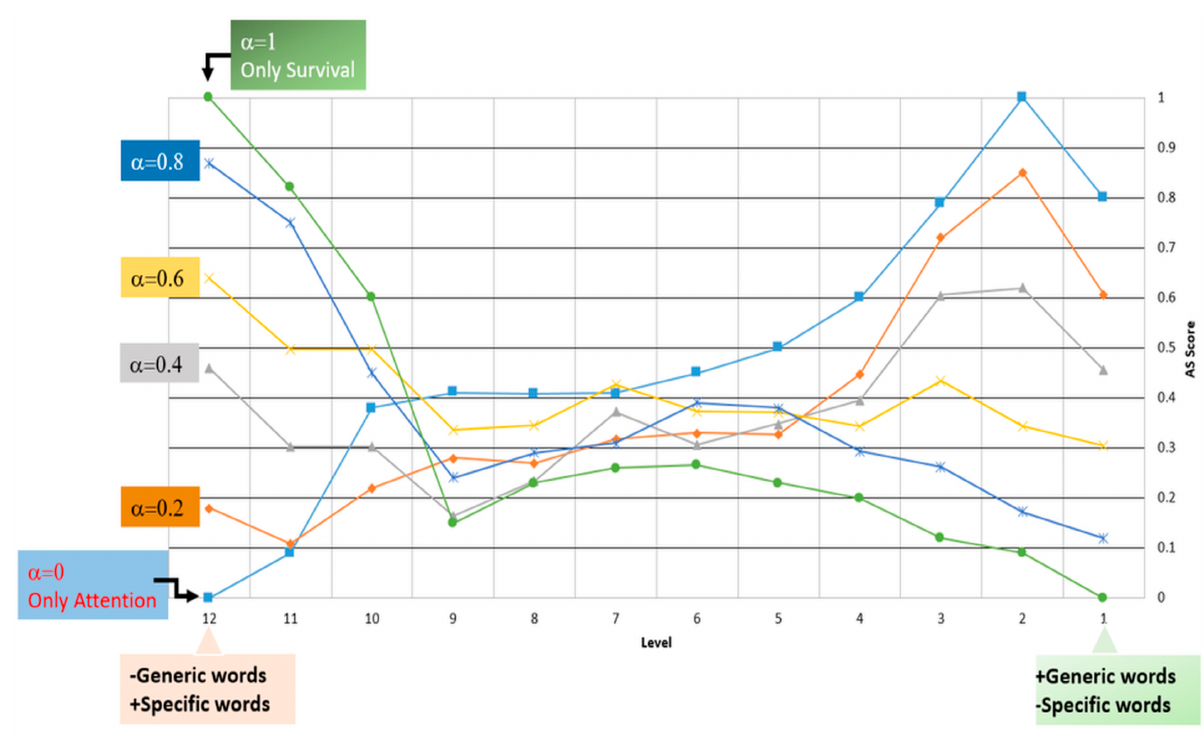
Figure 9. Behavior of the AS score for CSO based on different α parameter values.